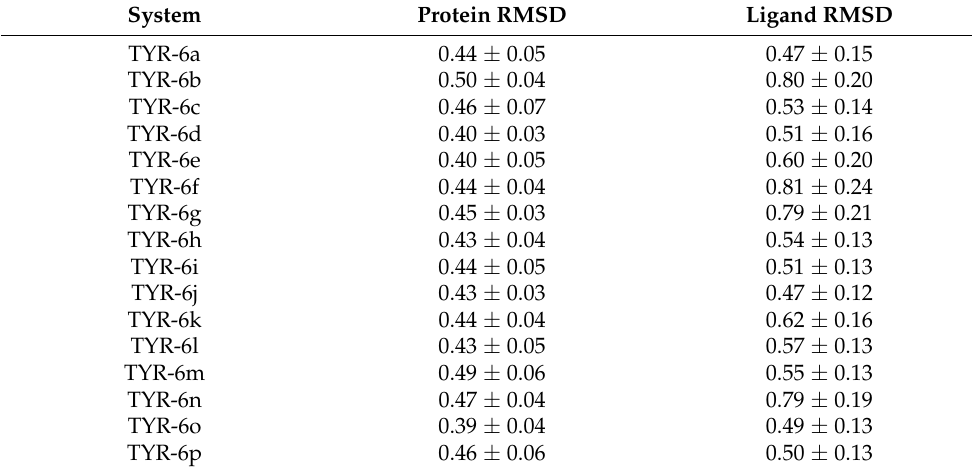
Table 2. RMSD values (in Å) for protein and ligand atoms from TYR systems.